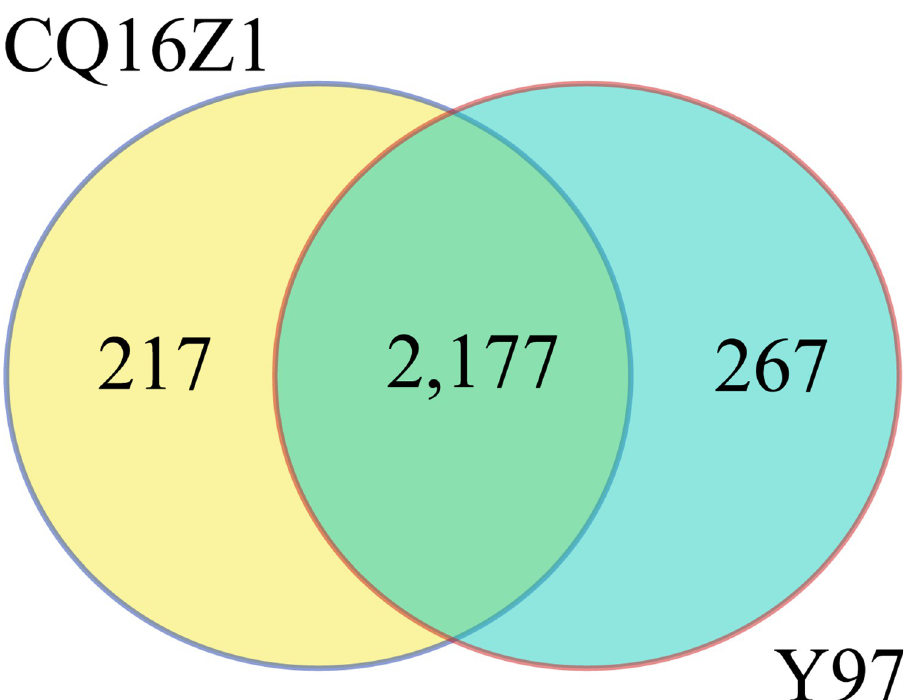
Fig 4. Number of shared genes and unique genes of CQ16Z1 and Y97. 1. = The left part represented unique genes of CQ16Z1, the right part represented unique genes of Y97, and the overlapping part in the middle represents the shared genes of the two strains.